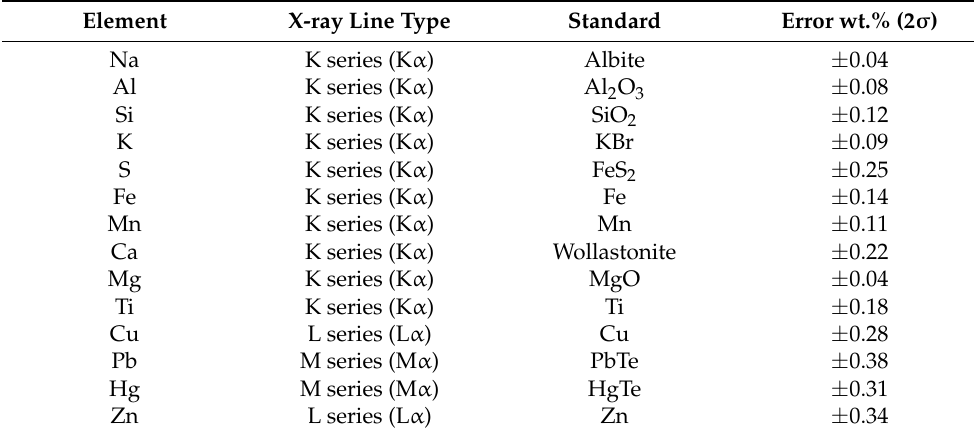
Table 2. Uncertainty and internal standards for SEM-EDS